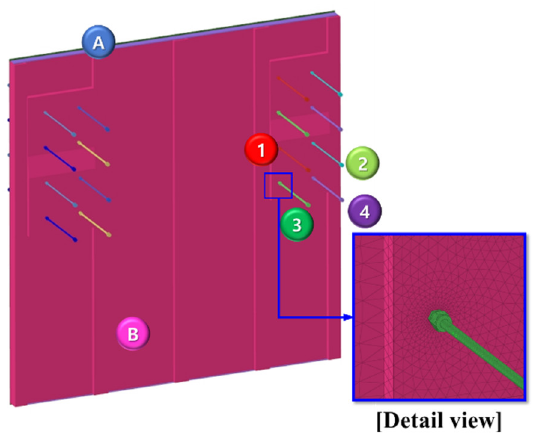
Figure 4. Configuration of the fire test specimen.